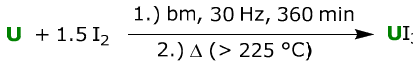
Figure 2. PXRD (full range, left; enhanced, right) of EuI 2 (black) showing two distinct